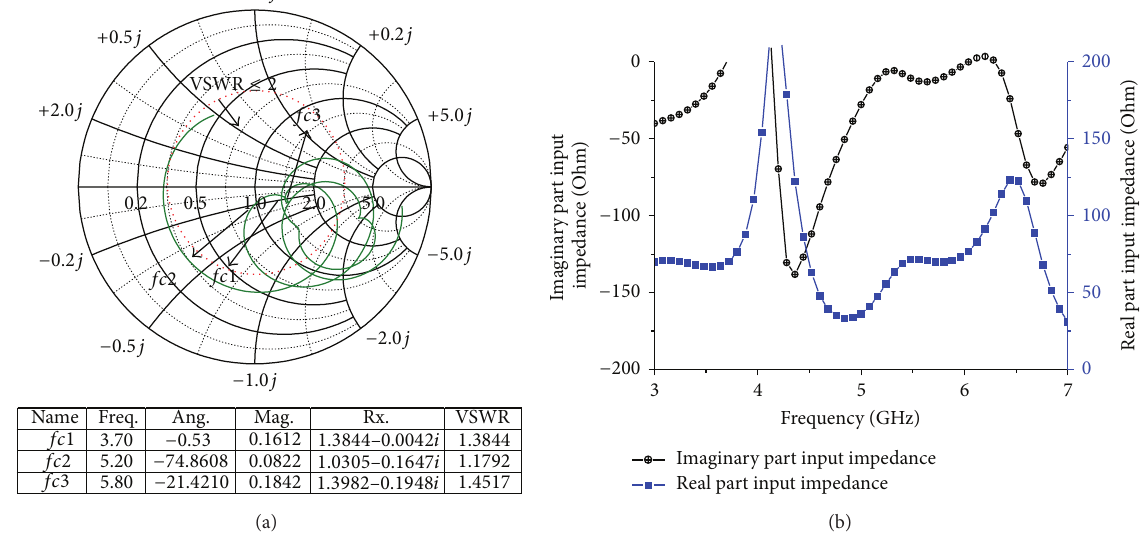
Figure 11: Proposed antenna (a), Smith chart, and (b) input impedance.